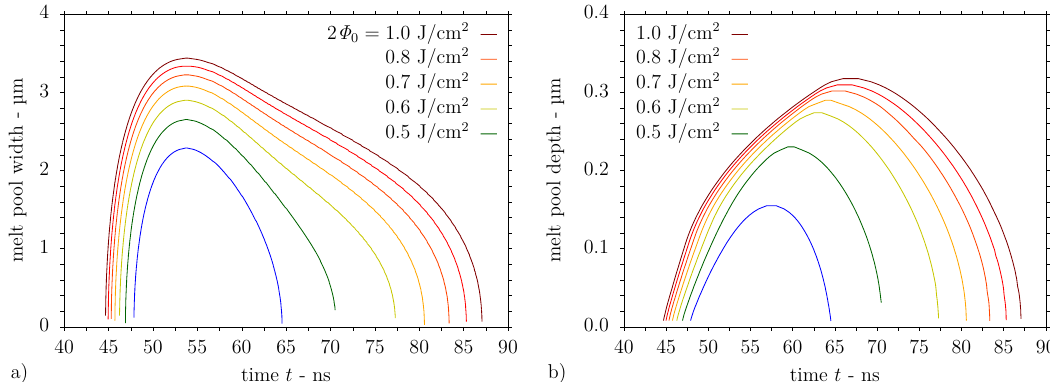
Figure 4. Evolution of melt pool dimensions during single pulse DLIP of AISI 304 stainless steel as determined by the SPH model for different laser fluences: ( a ) melt pool width and ( b ) melt pool depth.